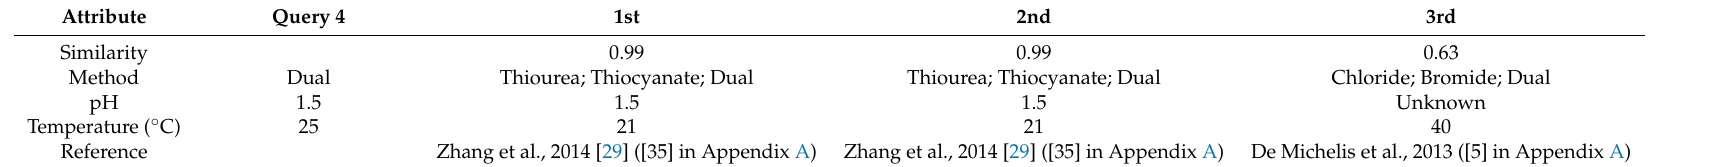
Table 8. Query 4 (Dual Lixiviant) and all the retrieved articles according to